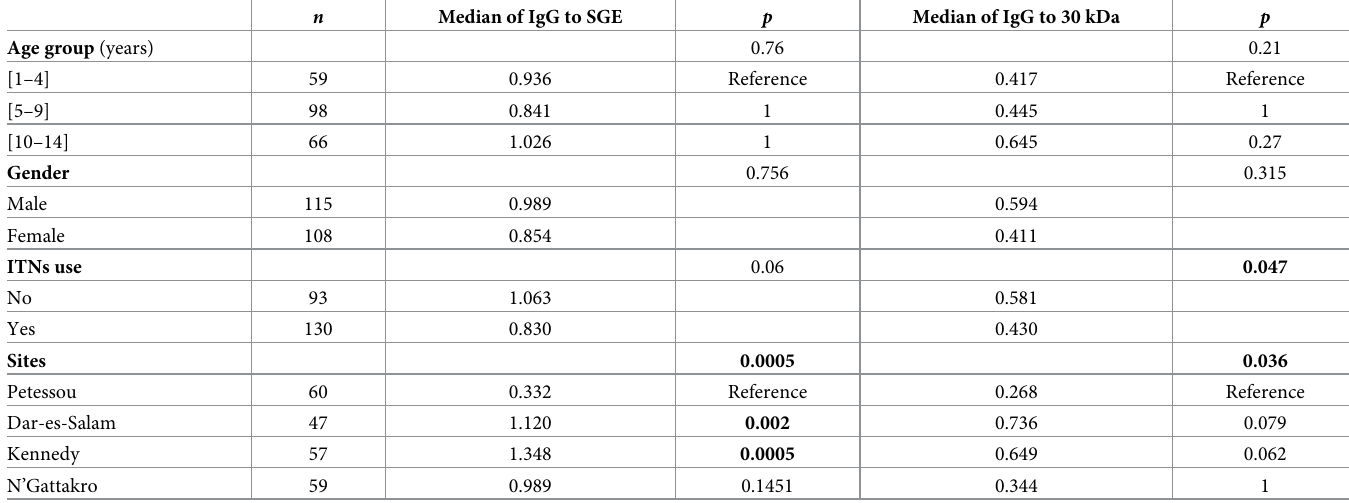
Table 2. Univariate analysis of IgG Ab level (median) against SGE and the 30 kDa protein. n